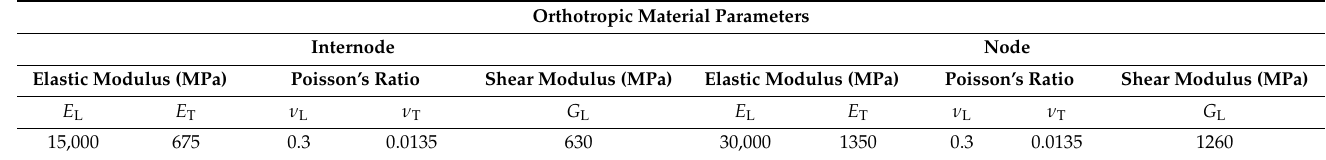
Table 4. Orthotropic material parameters used in FEM simulation.